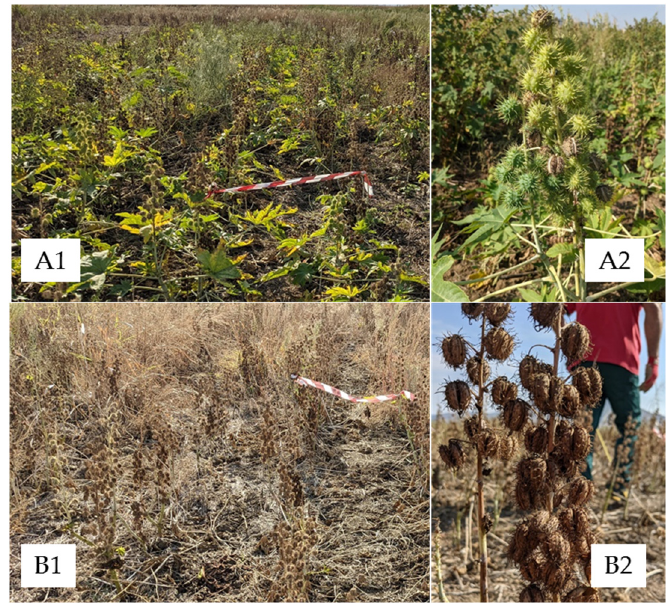
Figure 4. Difference between control ( A1 , A2 ) and terminated castor plants ( B1 , B2 ).